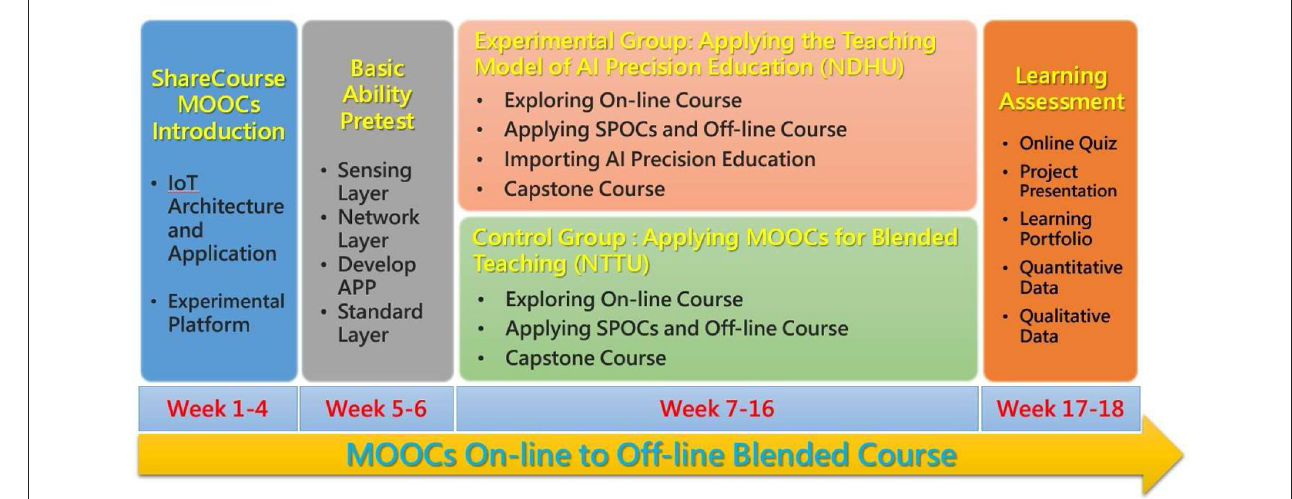
FIGURE 2 | Course experiment